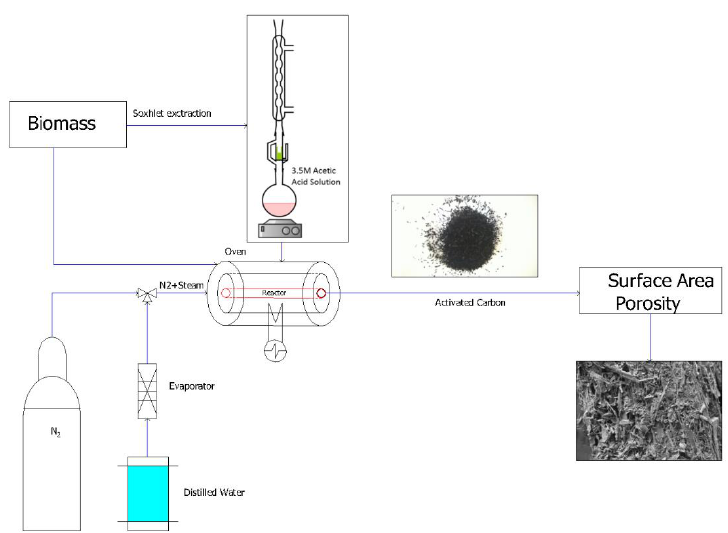
Figure 1. Scheme and reactor setup for extraction, carbonization, and activation.